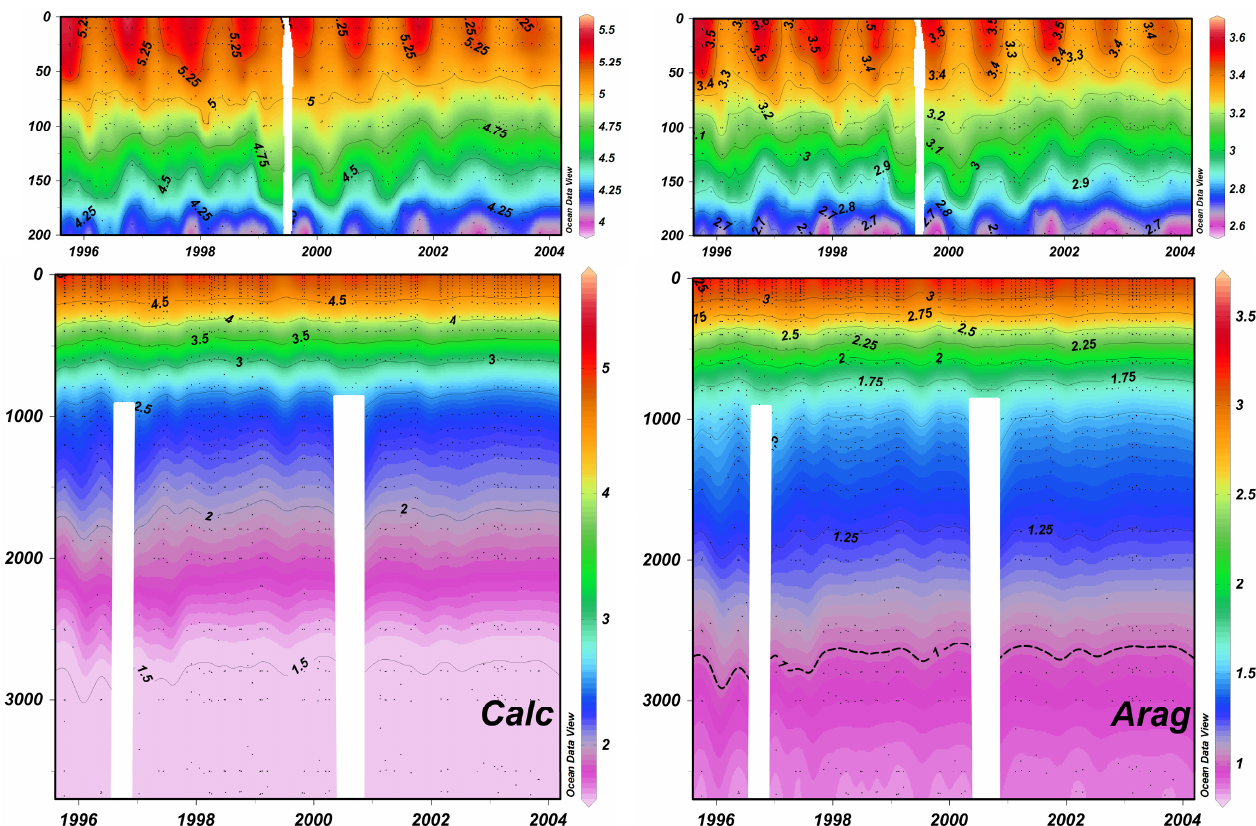
Fig. 6 Fig. 6. Hovm¨oller diagram of the water column calcite saturation state, (cid:127) calc , and aragonite saturation state, (cid:127) Arag